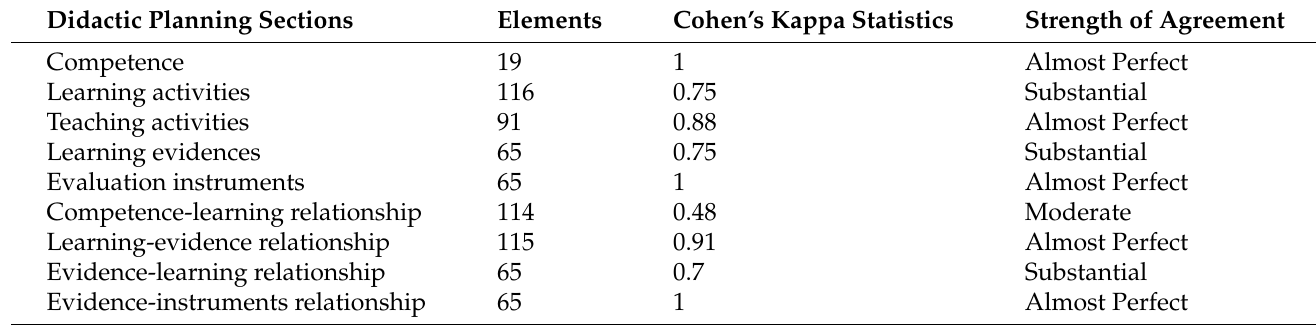
Table 7. Cohen’s Kappa test